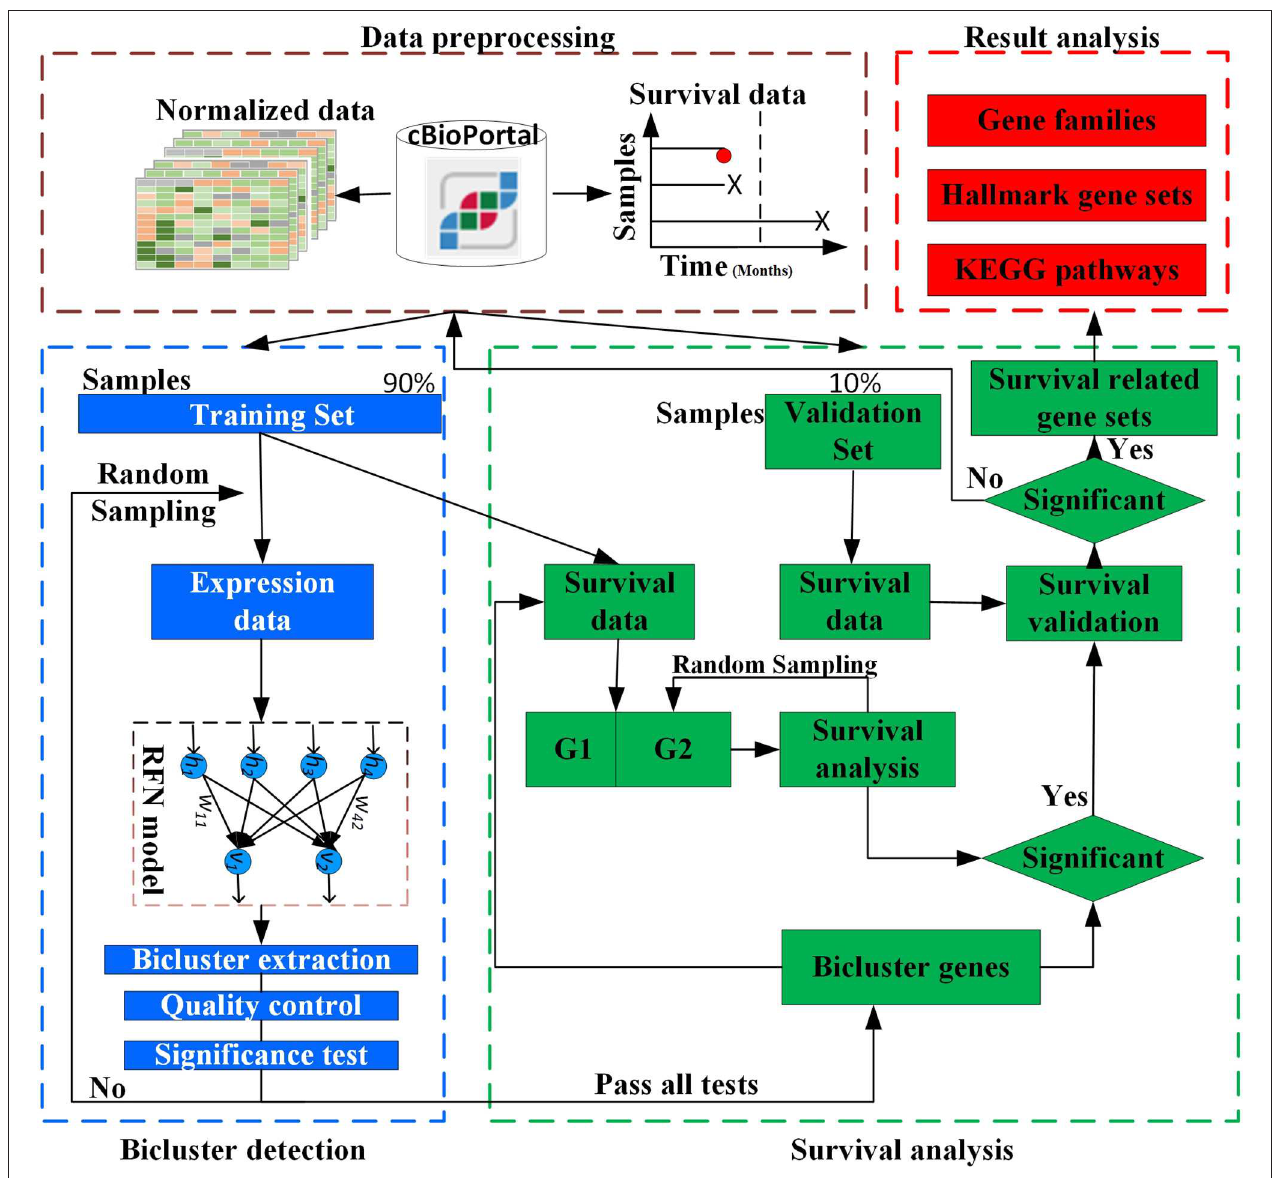
FIGURE 1 | Overview of